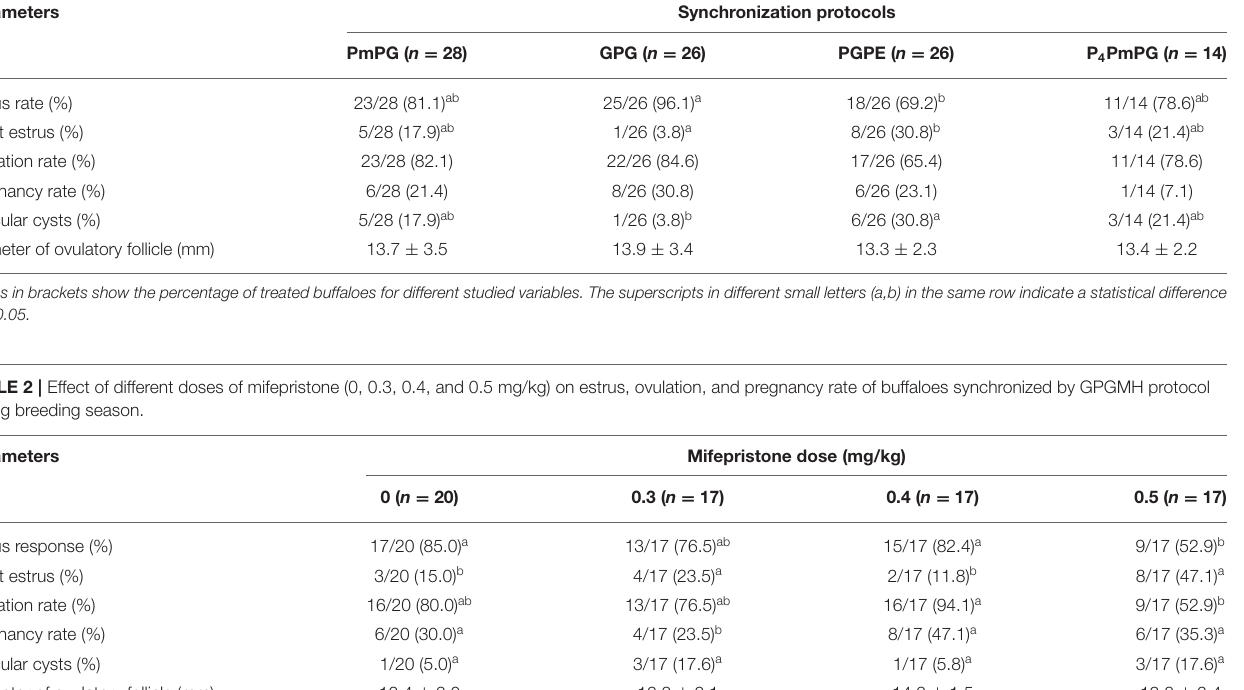
Values in brackets show percentage of treated buffaloes for different parameters. The superscripts in different small letters (a,b) in the same row indicate statistical difference P <